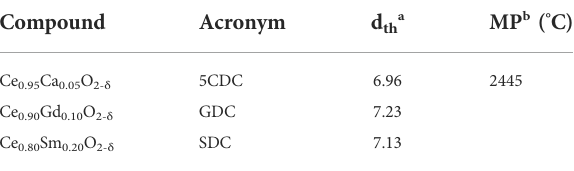
TABLE 1 List of acronyms and selected physical properties of single- phase electrolytes (Duran et al., 1990; Zha et al., 2003; Maheshwari and Wiemhöfer,